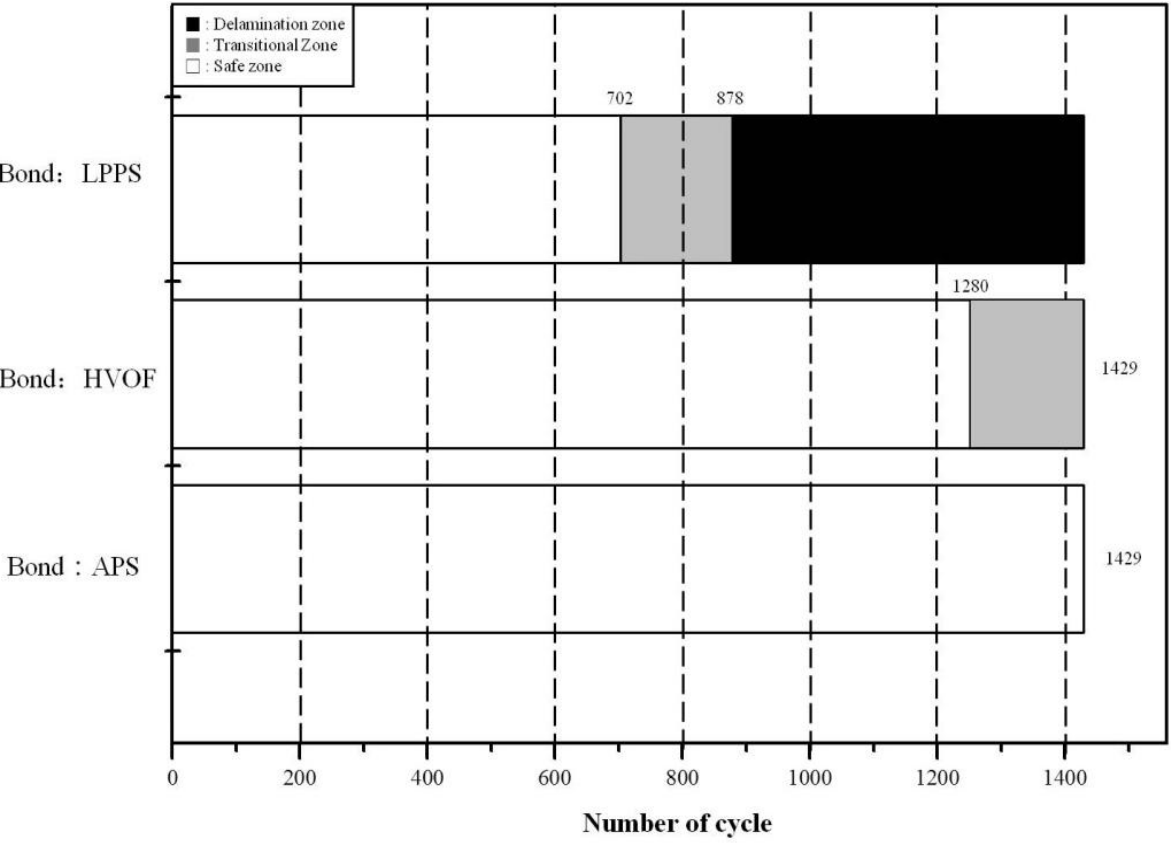
Figure 5. The lifetime of TBCs with different bond coats after CFTF tests as a function of cycle